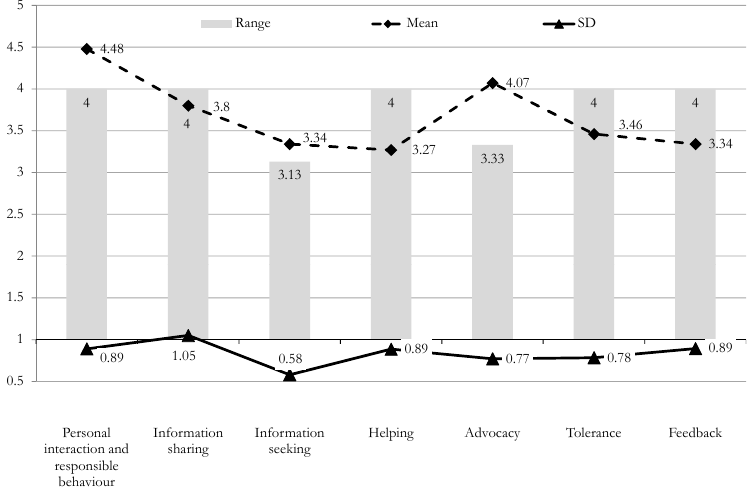
Fig. 5 – Descriptive statistics of the factors – customers’ participation and citizenship behaviour Source: own